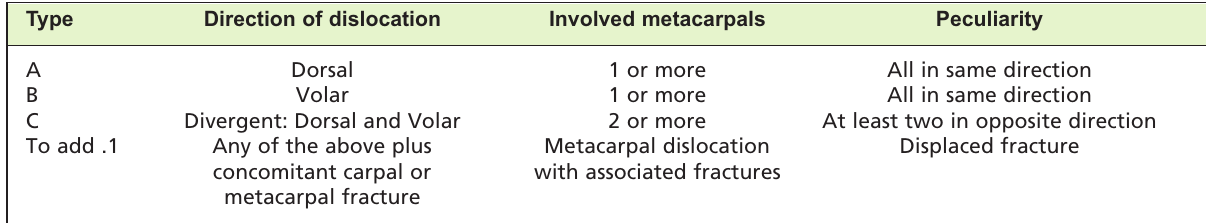
Classification of Carpo-Metacarpal (CMC) joint dislocation Table I: